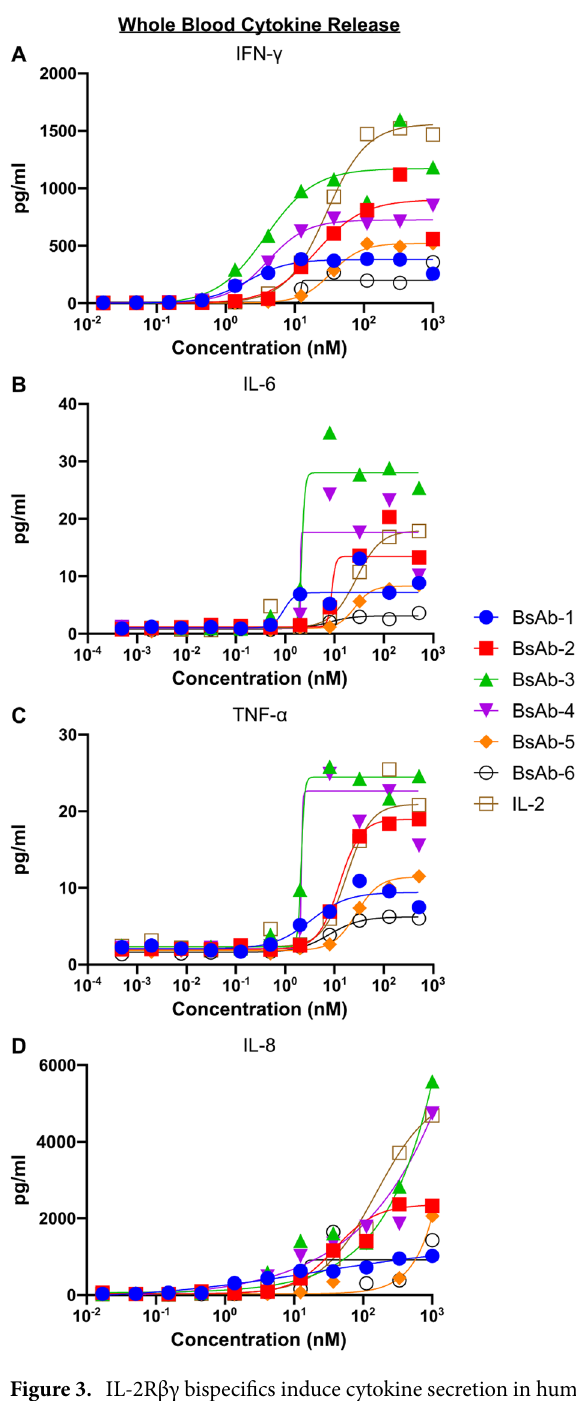
Figure 3. IL-2Rβγ bispecifics induce cytokine secretion in human whole blood. ( A to D ) Fresh human whole blood was incubated overnight with a range of doses of IL-2Rβγ bispecific UniAbs or IL-2. Plasma was then separated by centrifugation and tested by MSD for IFN-γ ( A ), TNF-α ( B ), IL-6 ( C ), and IL-8 ( D